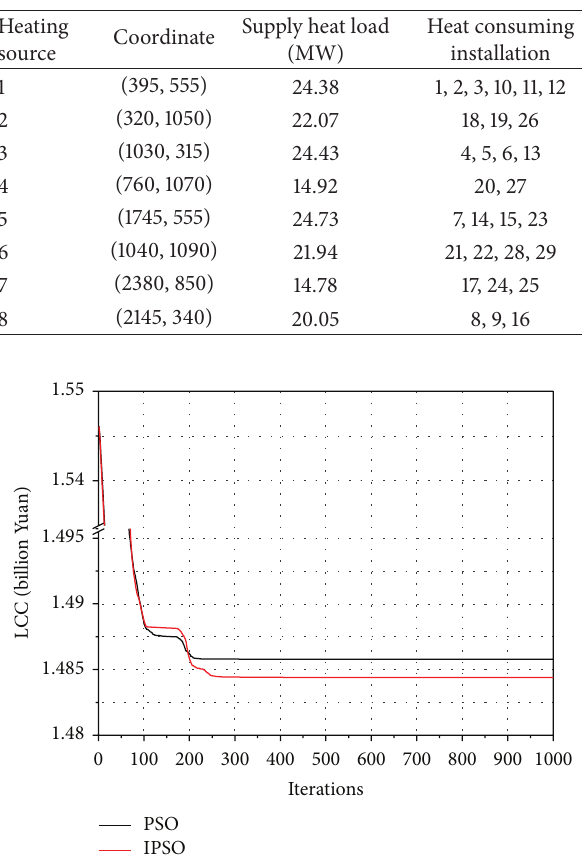
Table 3: The detailed results of 8 heat sources scheme.